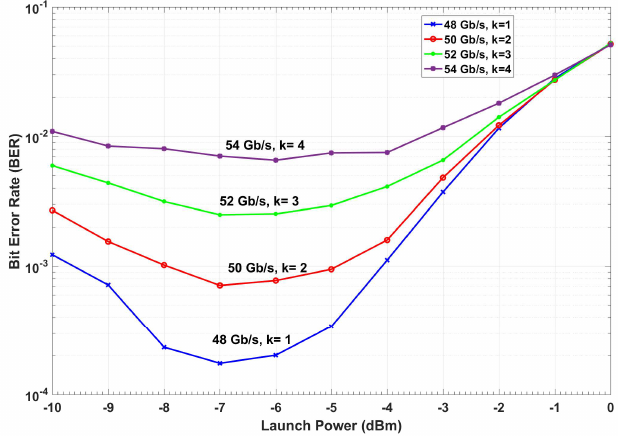
Figure 15. The simulation of a conventional system with a linear equalizer.